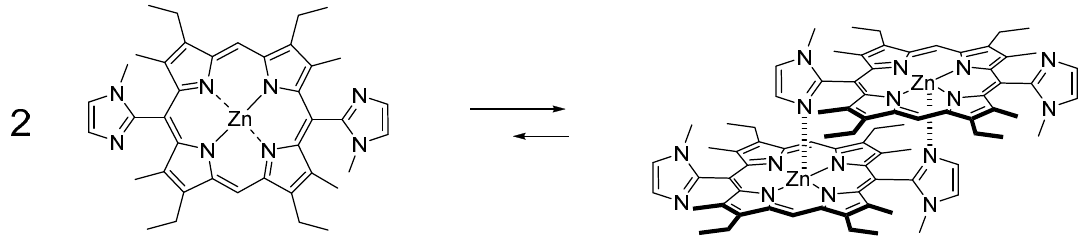
Figure 2. An imidazole zinc porphyrin (ImZnP) and its self-assembled dimer.